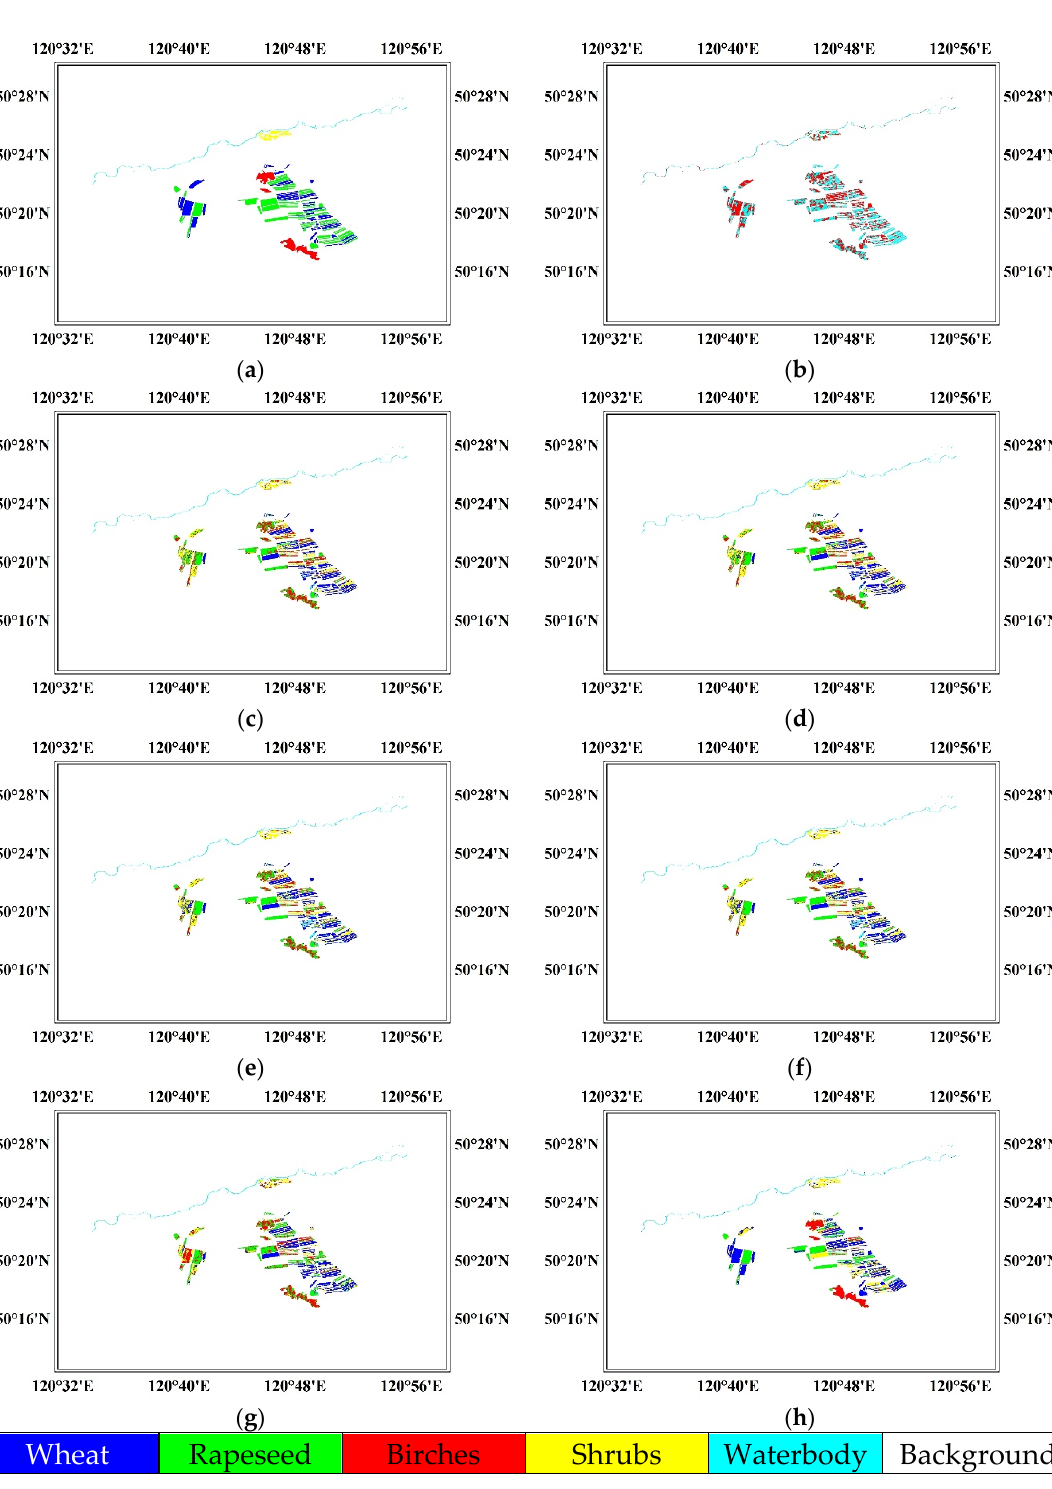
Figure 9. Ground truth map and classification maps in Erguna (SD: A -> TD: B), generated by different methods: ( a ) Ground truth; ( b ) DAC; ( c ) TCA+DAC; ( d ) SSTCA+DAC; ( e ) MIDA+DAC; ( f ) SMIDA+DAC; ( g ) SMbDA+DAC; ( h ) WSMbDA+DAC.